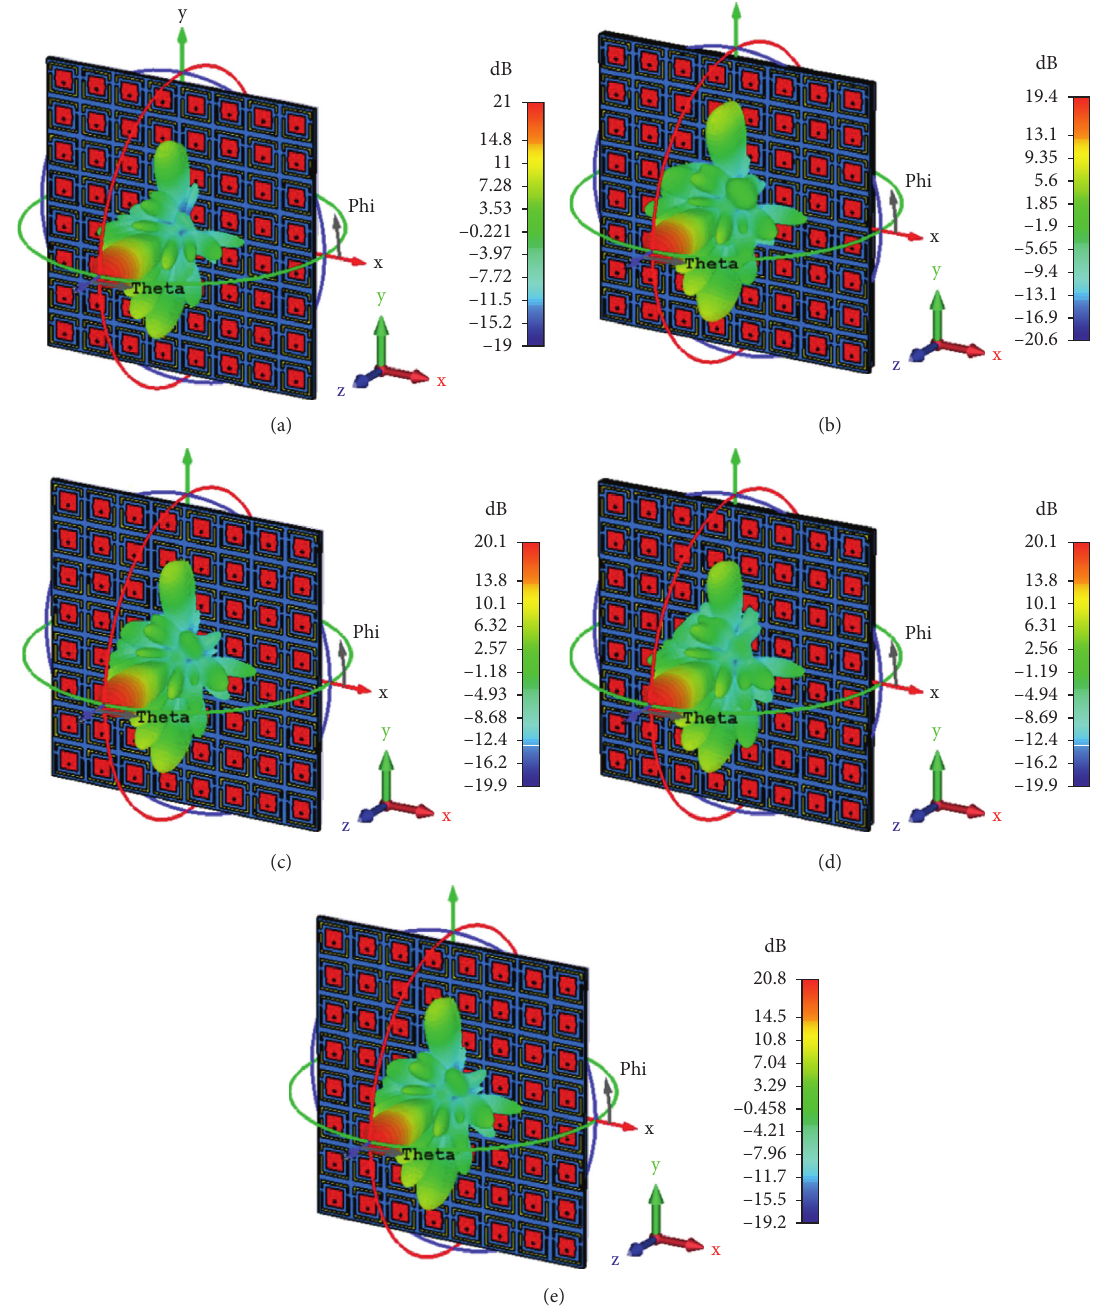
Figure 8: Simulated 3D radiation pattern of different layouts; (a) 3D radiation pattern of reference antenna (when all PIN diodes are of “ON” states); (b) 3D radiation pattern of reference antenna (when all PIN diodes are of “OFF” states); (c) 3D radiation pattern of checkerboard layout; (d) 3D radiation pattern of new chessboard layout; (e) 3D radiation pattern of “0101” square ring nested